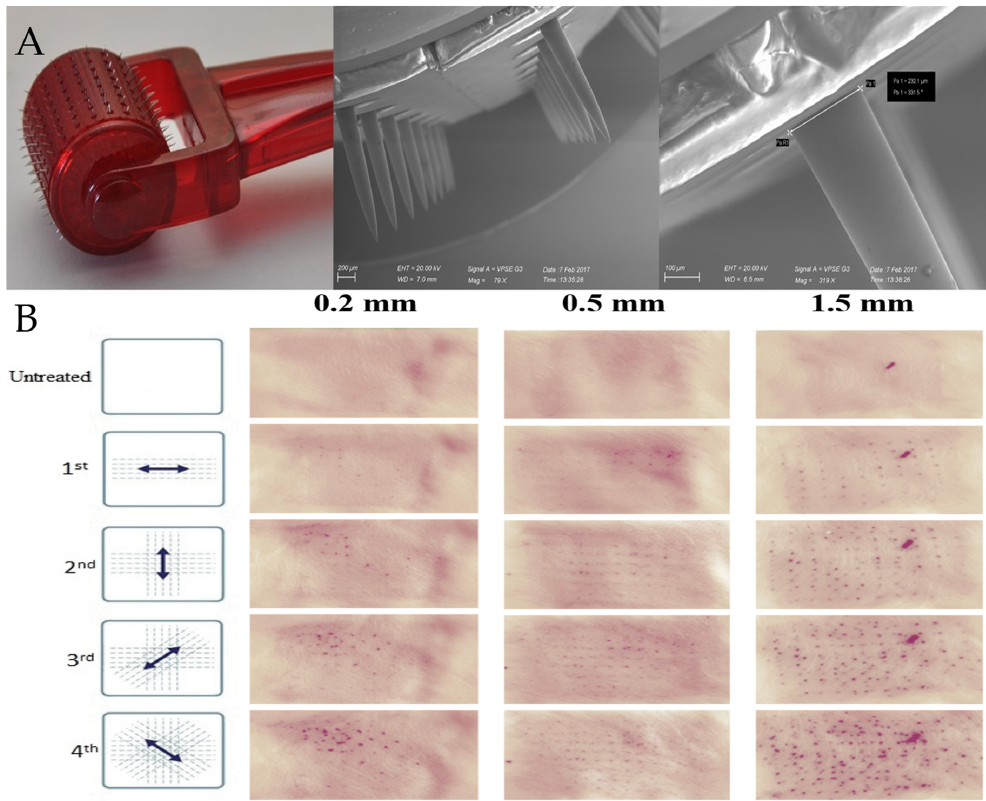
Figure 2. ( A ) Representative images (digital camera and SEM) of a stainless-steel microneedle roller, DermaQ ® (density of 192 microneedles and needle length of 1.5 mm). ( B ) Visualization of